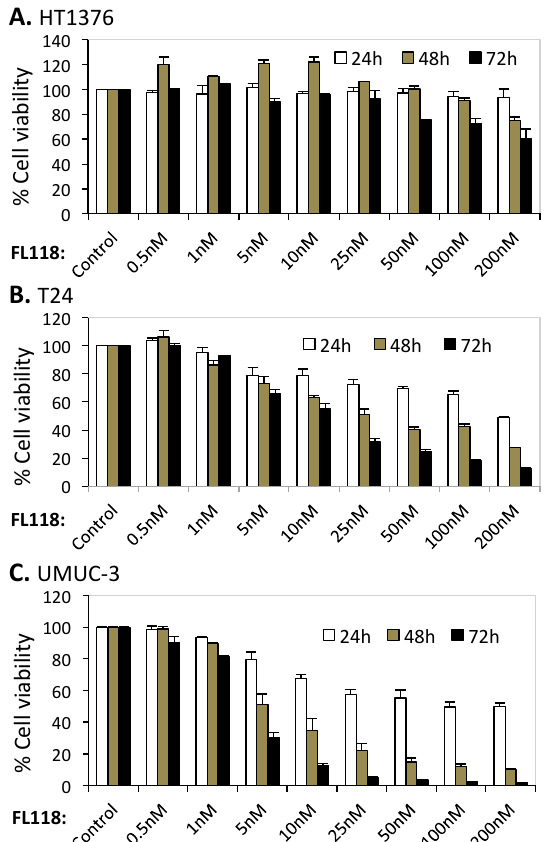
Figure 1. Di ff erential inhibition of human bladder cancer cell growth by FL118. Subconfluent bladder cancer cells HT1376 (wild-type Ras), T24 (Hras G12V mutant) and UMUC-3 (Kras G12C mutant) in 96-well plates were treated with either DMSO (control) or a series of FL118 concentrations for 24 h–72 h followed by MTT assay to determine cell viability. ( A ) HT-1376 cells with wild-type Ras were insensitive to FL118 treatment compared to other cell lines (T24, UMUC-3). ( B , C ) Ras mutant T24 and UMUC-3 cells are highly sensitive to FL118 treatment. Each bar in the histogram shown in ( A – C ) is the mean ± SD from three independent